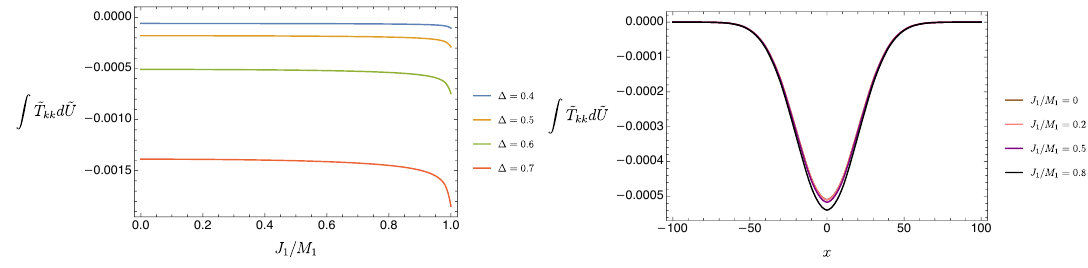
˜ ˜ T kk d U at x 1 = 0 (left) = 1 r = 100 , N + , 2